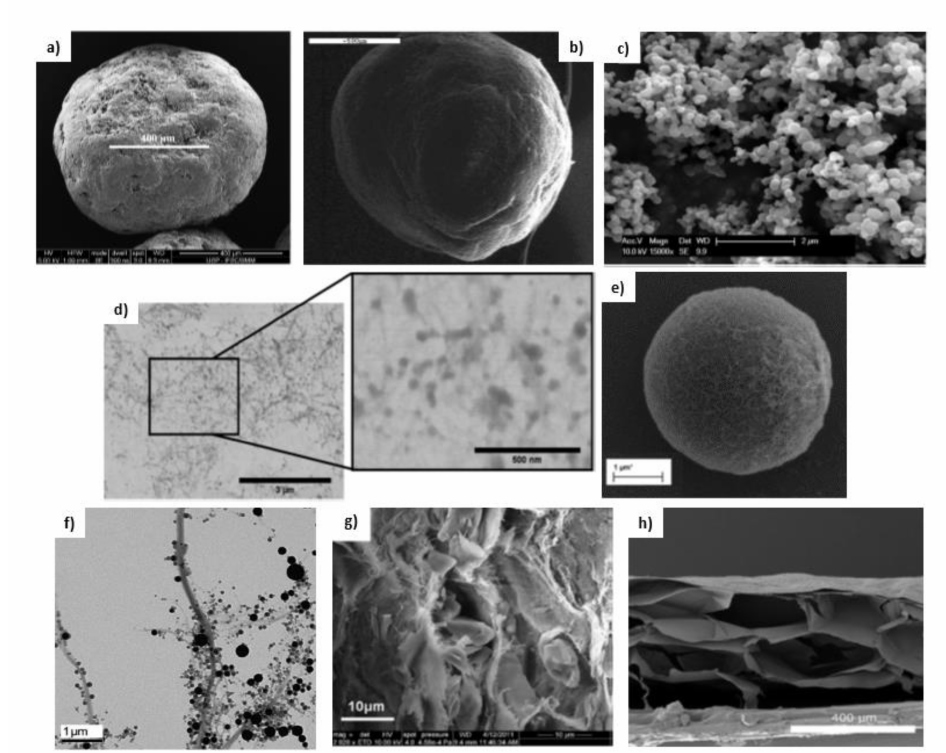
Figure 6. SEM images of: ( a ) MCC microparticles coated with a lipid-based system loaded with Rosmarinus officinalis extract added with maltodextrin and gum arabic [91]; ( b ) liquid-pellets of naproxen (as model compound) containing MCC, Tween 80, hydrophilic fumed silica and sodium starch glycolate [93]; ( c ) MCC particles coated with curcumin (as model compound) and PVP [94]; ( d ) nanocomplexes of tannic acid and decylamine modified CNC encapsulating curcumin [5]; ( e ) CNC and chitosan microcapsules encapsulating curcumin [15]; ( f ) HFBI coated nanoparticles entrapping itraconazole immobilized in a CNF and trehalose matrix [144]; ( g ) itraconazole loaded CNF films [149]; ( h ) CNF nanofoams loaded furosemide [117]. Reprinted with permission from refs. [5,15,24,25,122,124,150,176]. Copyright 2020